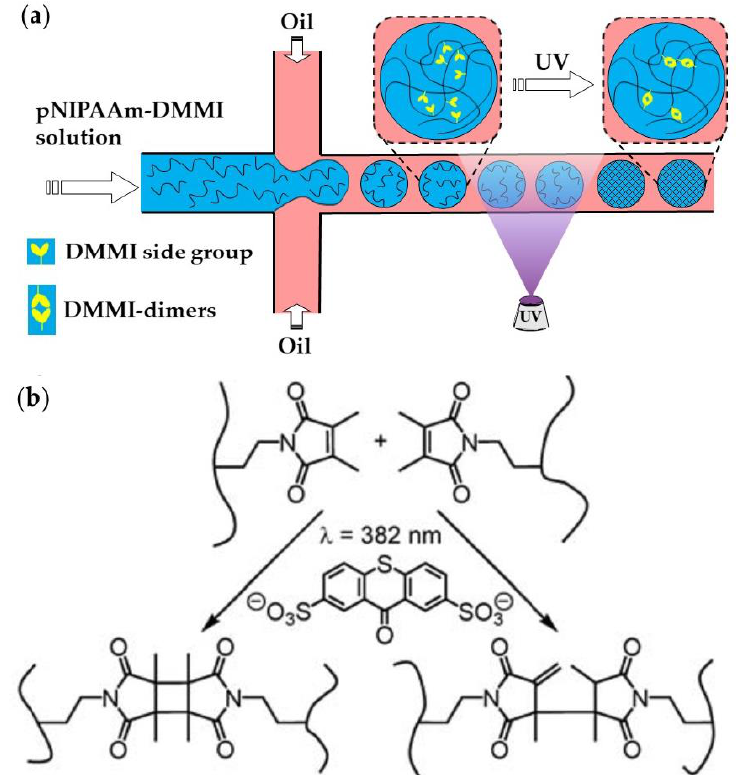
Figure 23. ( a ) Microfluidic synthesis of poly( N -isopropylacrylamide-dimethylmaleimide) microgels by Photopolymerization. ( b ) Polymer crosslinking by dimerizing side DMMI groups in the presence of thioxanthone-2,7-disulfonate (TXS). Two isomeric types of DMMI-dimers are formed [93].